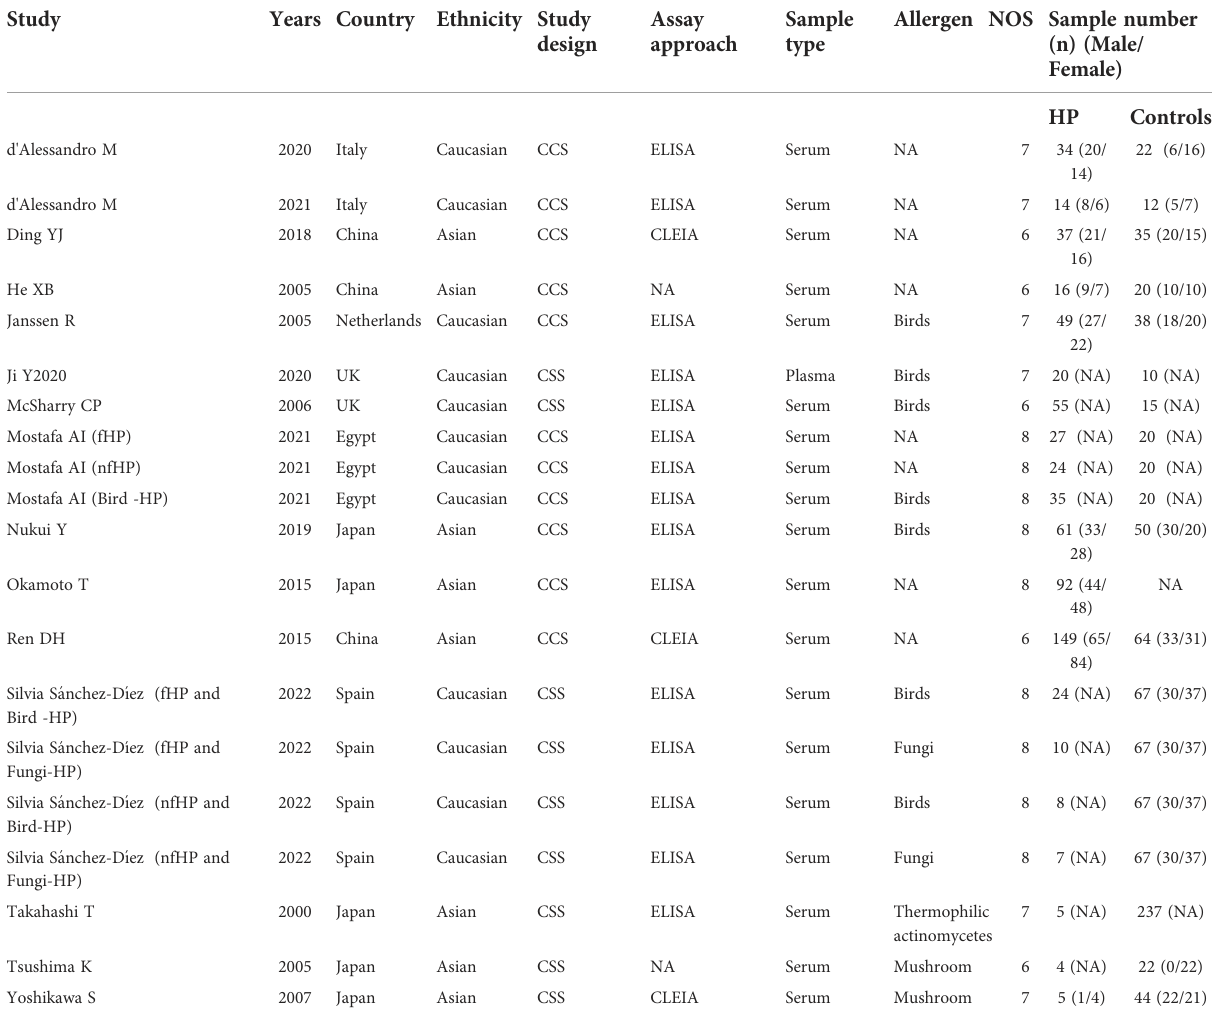
TABLE 1 Characteristics of included